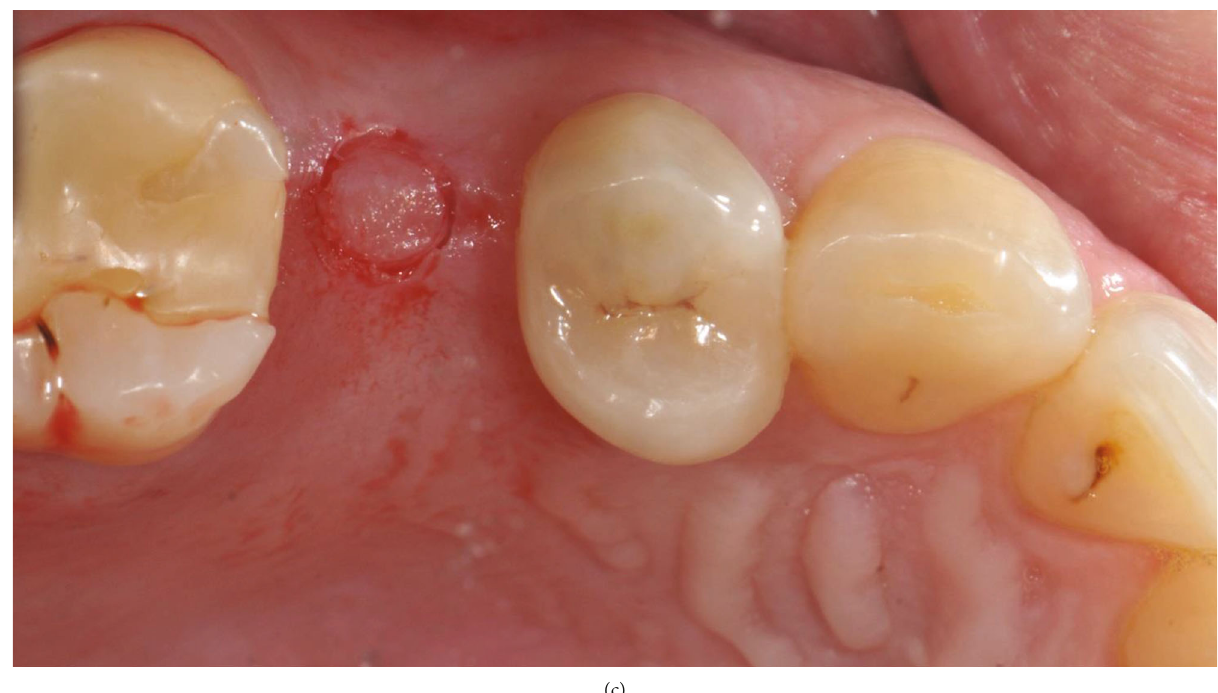
Figure 4: (a) Template positioning before the surgery. (b) Rotating circular tissue punch. (c) Operculectomy through the